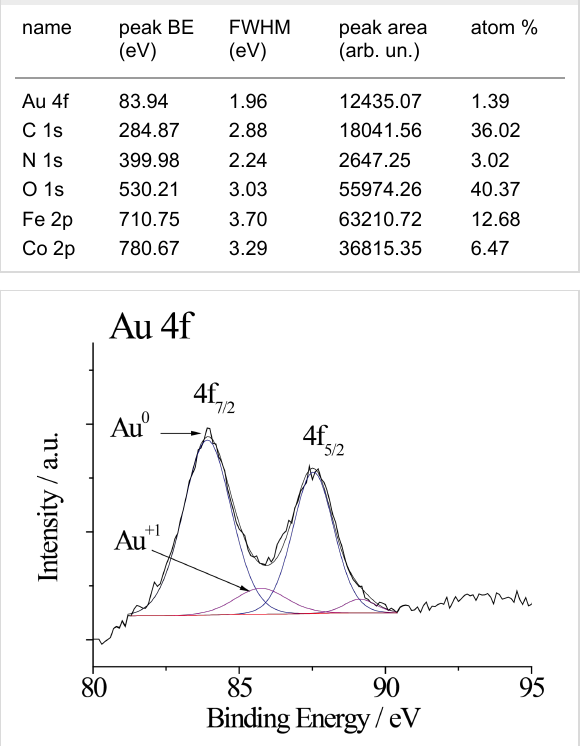
Figure 5: Deconvoluted X-ray photoelectron spectrum (XPS) of Au